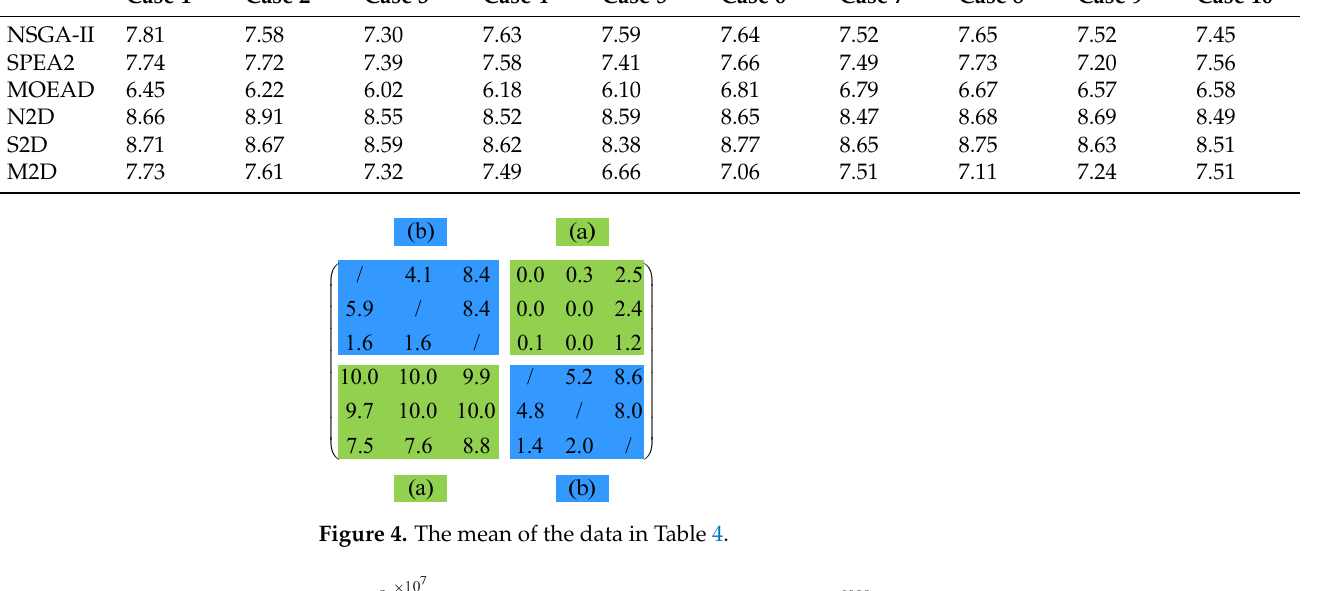
Table 6. The calculation results of * 3 M (Order of magnitude 10 × ).